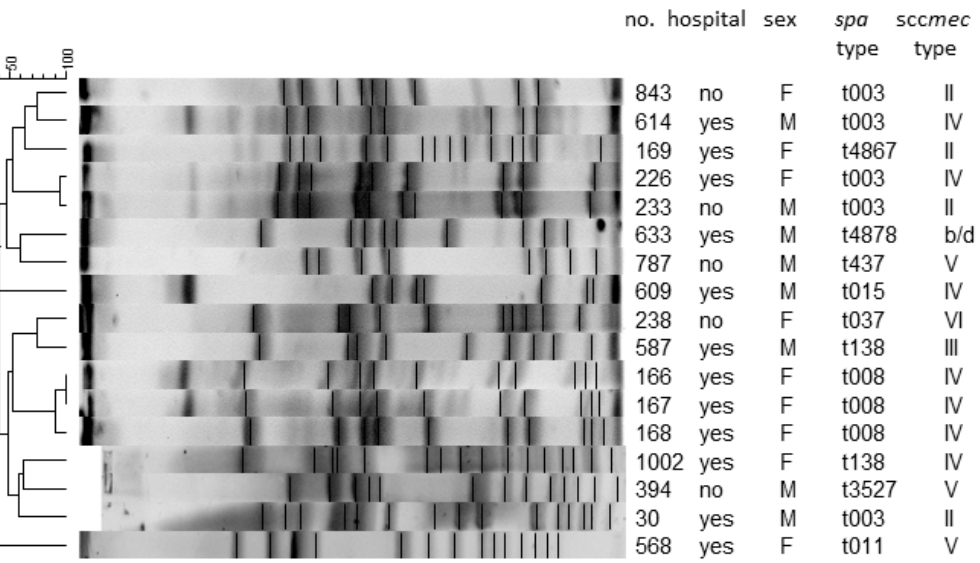
Figure 2. Analysis of the genetic similarity between S. aureus isolates by the PFGE (Pulsed-Field Gel Electrophoresis) method based on spa and sccmec genes.